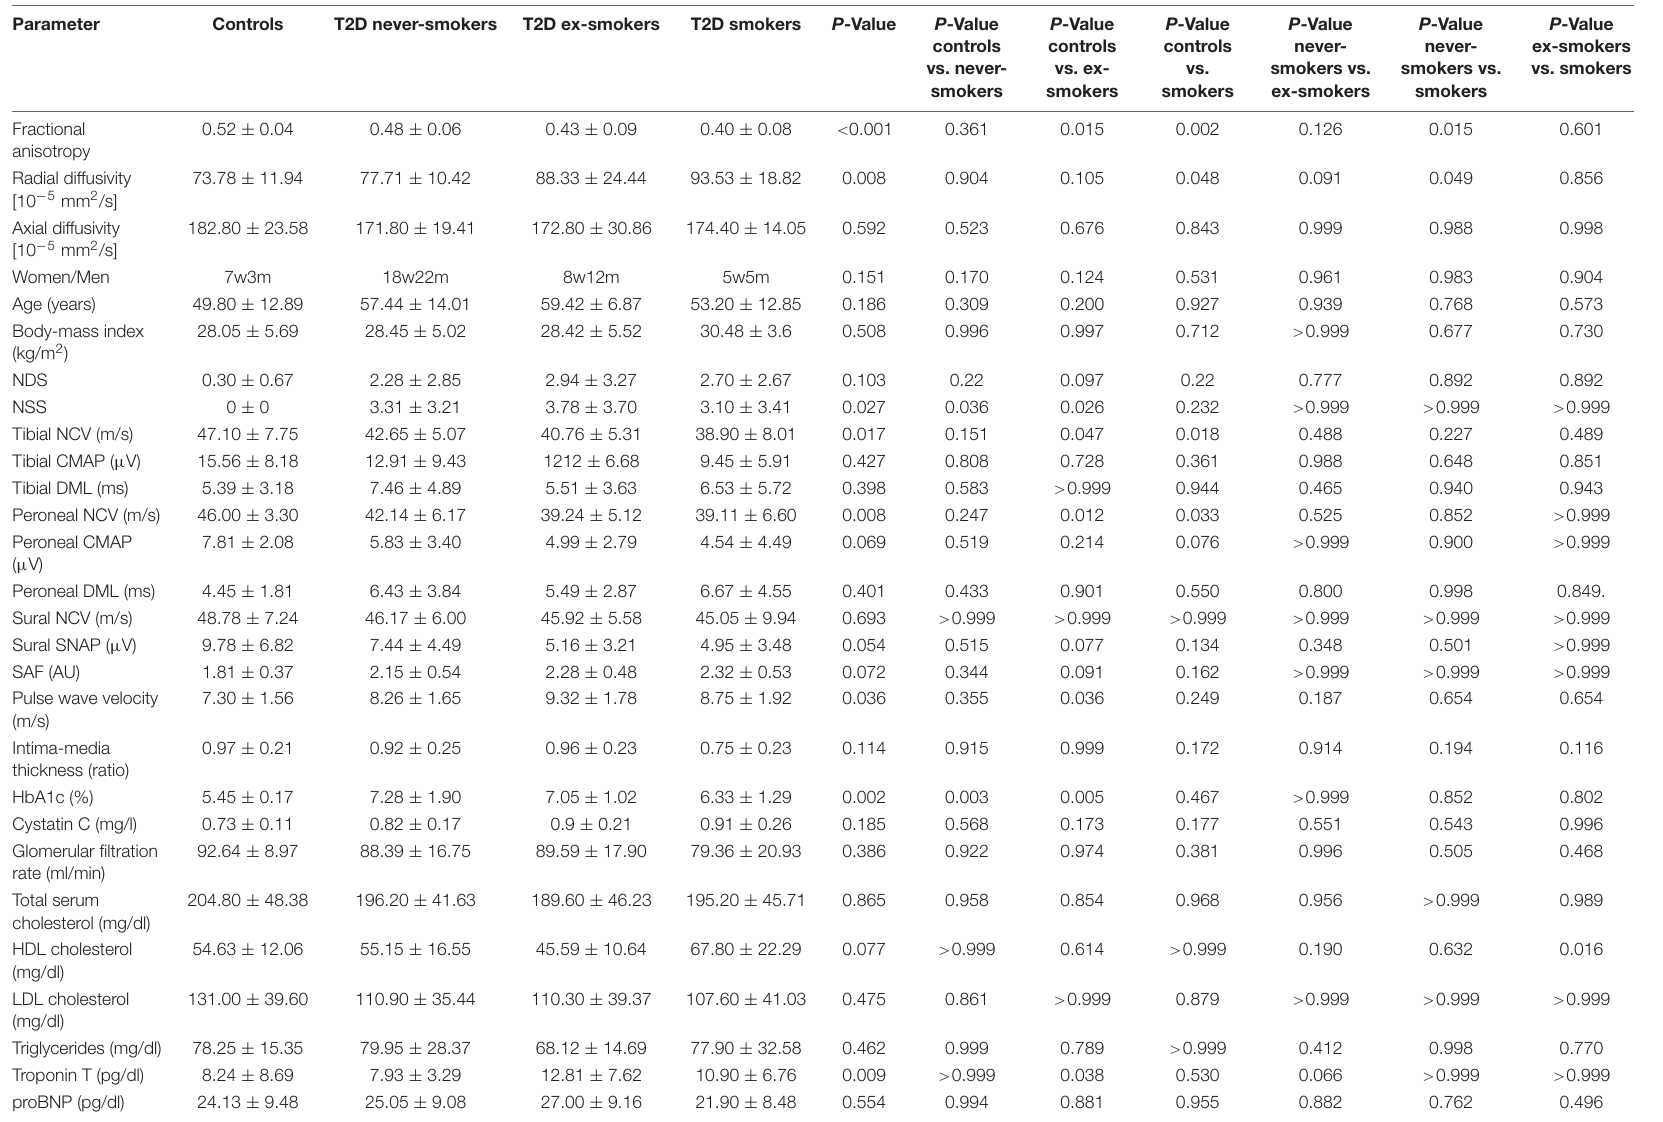
TABLE 1 | Comparison of imaging, clinical, electrophysiological, apparatus-bound, and serologic parameters between controls, type 2 diabetes (T2D) never-smokers, ex-smokers, and smokers.